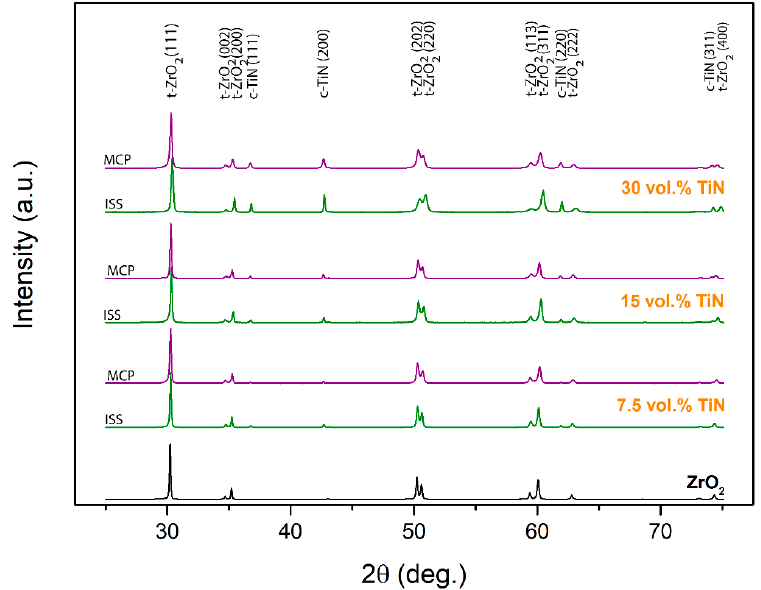
Figure 2. XRD patterns of SP-sintered nanocomposites for various powder compositions prepared by ISS (green) and MCP (purple) fabrication routes.